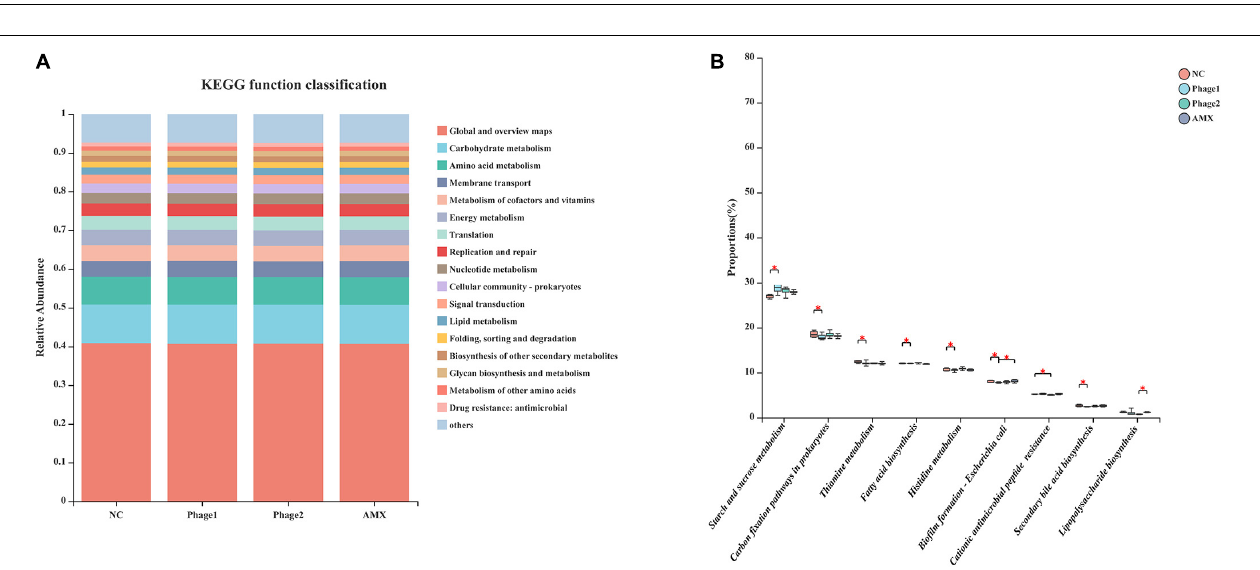
FIGURE 9 | LEfSe analysis of cecal microbiota. Cladogram (A) and LDA scores (B) show taxa that best characterize each biological class. Different-colored regions represent different constituents. Circles indicate phylogenetic level from domain to genus. The diameter of each circle is proportional to the abundance of the group. Species with significant difference that have an LDA score greater than the estimated value (3.0). The length of the histogram represents the LDA score. NC, negative control; Phage 1, 10 9 PFU GRNsp6 (day 3-5); Phage 2, 10 9 PFU GRNsp6 (day 8-10); AMX, 1 mg/ml amoxicillin (day 8-10).